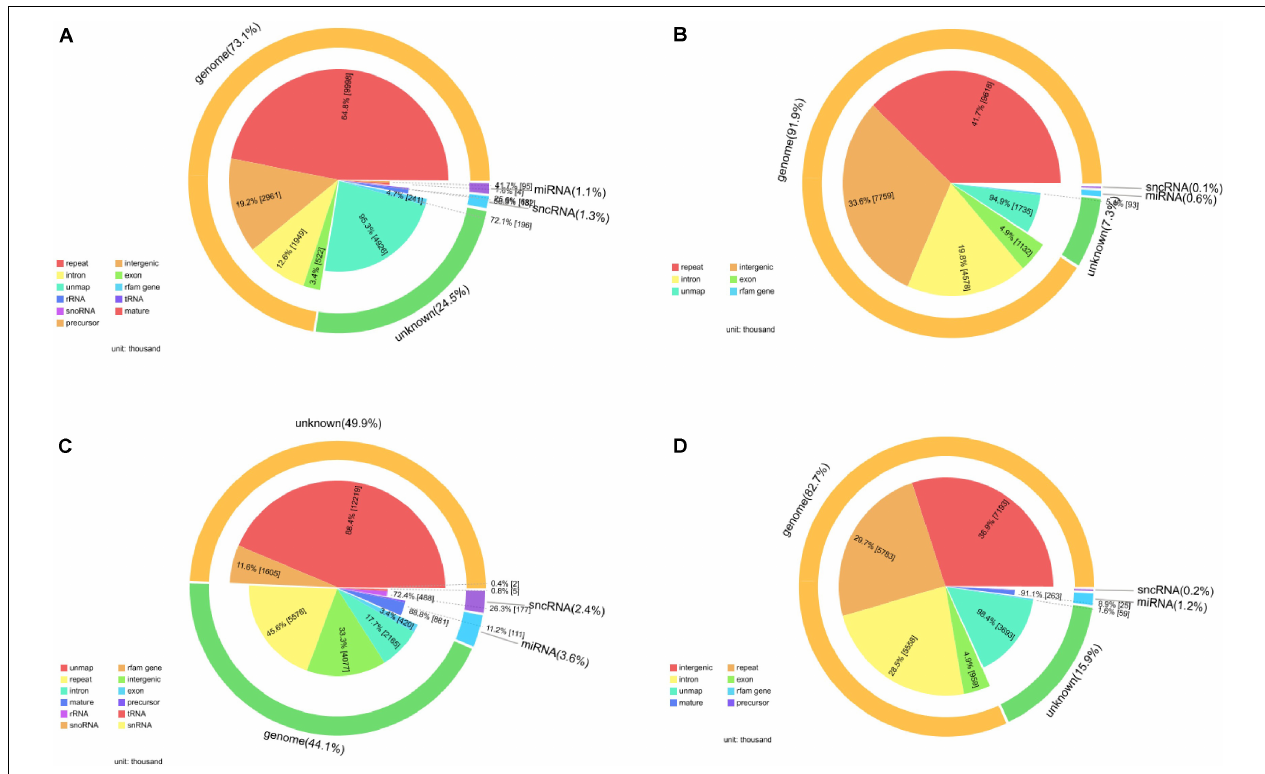
FIGURE 3 | Catalog of small RNAs in four sequencing groups. (A) Negative control group; (B) positive control group; (C) P-ONE group; (D) P-TWO group. For all the four samples, most of the so-called small RNAs all come from the genome especially the intergenic regions and only about 5% of all the small RNAs can be defined as microRNA or small non-coding RNAs. And for all the samples, there still remain thousands of unknown small RNAs for further exploration.